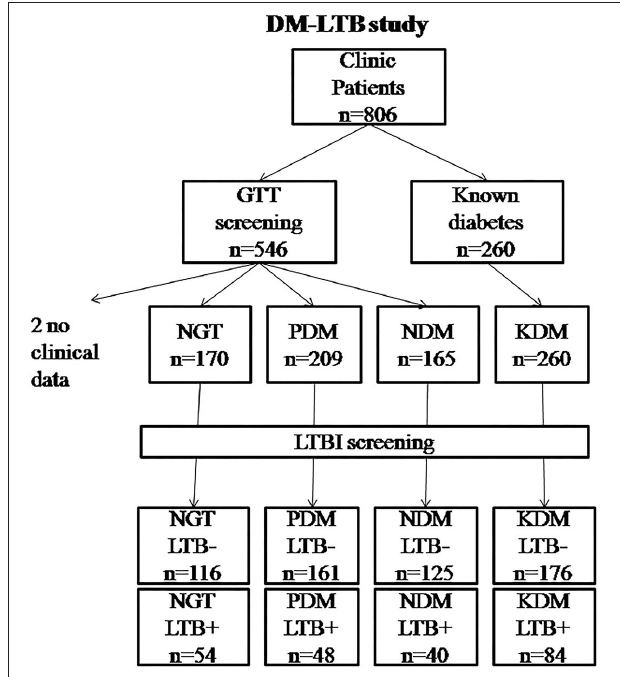
FIGURE 1 | Flowchart showing the recruitment of study subjects into the DM-LTB study. LTB screening was carried out using IGRA assay. Diabetic status was determined based on oral glucose tolerance test as per WHO criteria. For two patients, clinical data couldn’t be obtained and hence were removed from